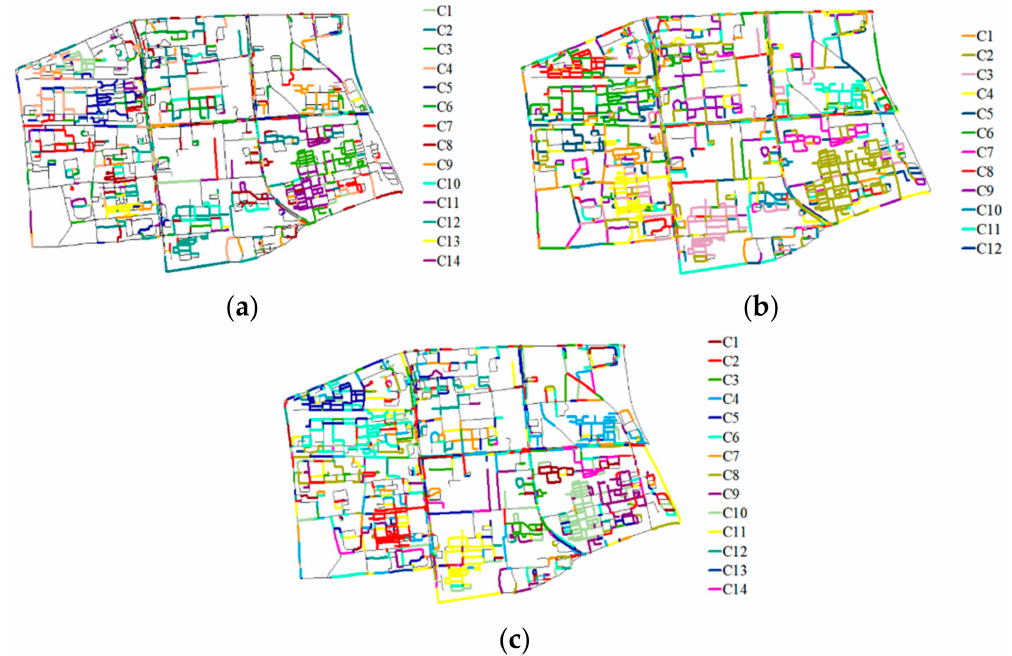
Figure 7. Communities identified by RWLA: ( a ) snapshot 1; ( b ) snapshot 2; ( c ) snapshot